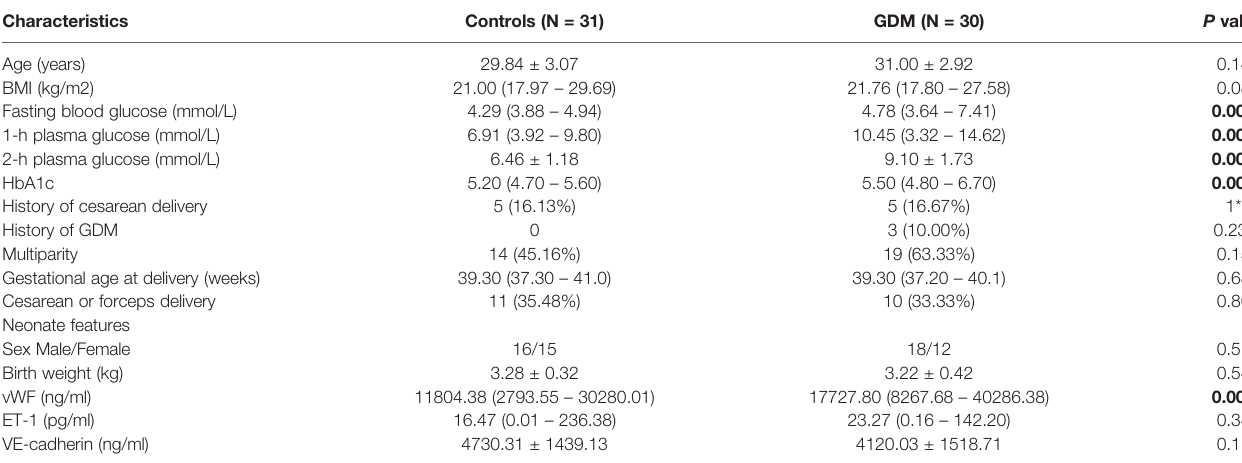
TABLE 1 | Characteristics of the study population.